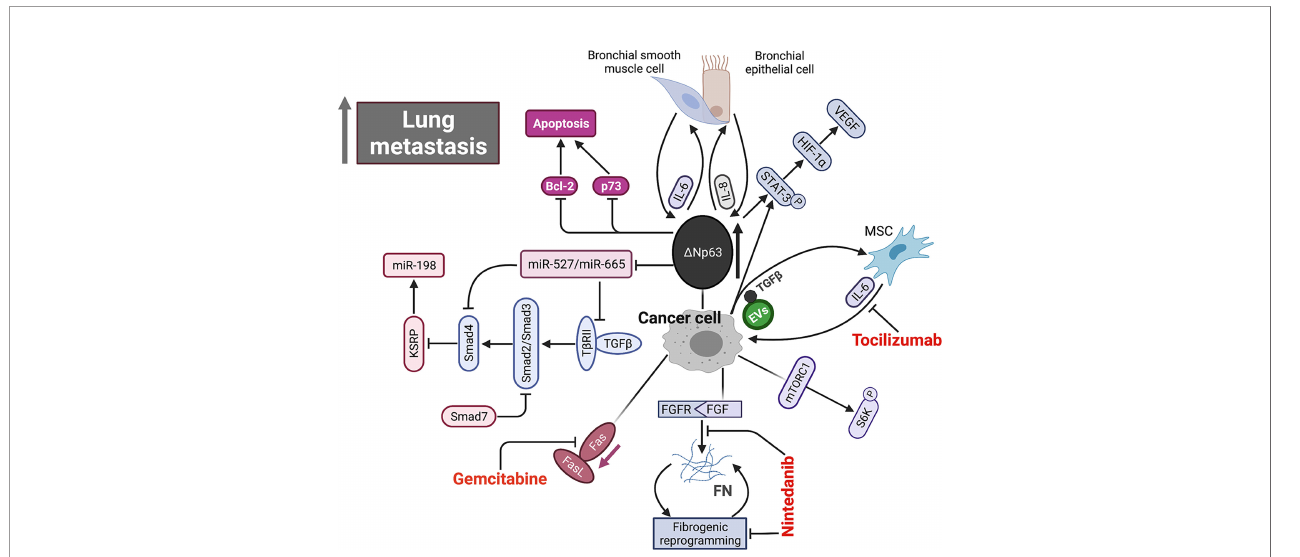
FIGURE 2 | Schematic representation of signaling pathways within microenvironment underlying OS metastasis. Aberrant overexpression of D Np63 in cancer cell directly drives feed-forward ampli fi cation of IL-6 and IL-8 production by the interactions between cancer cell and both primary bronchial epithelial cell and bronchial smooth muscle cell. D Np63 overexpression leads to elevated phosphorylation of STAT-3, which further activates HIF-1 a /VEGF axis. High expression of D Np63 promotes cancer cell survival by inhibiting Bcl-2 and p73-depedent apoptosis. In addition, D Np63 represses miR-527 and miR-665, leading to the upregulation of two TGF- b effectors, Smad4 and T b RII, which inhibits anti-metastasis miR-198 by suppressing its regulatory factor, KSRP. FGF signaling initiates and FN signaling sustains fi brotic reprogramming. Nintedanib targets the pan FGFR-FN axis to inhibit OS lung metastasis. Fas-negative OS cells are selected during metastasis by evading elimination in lung where Fas ligand (FasL) is constitutively expressed. Gemcitabine appears to be a promising agent by upregulating Fas expression. EVs secreted by OS cells selectively incorporate a membrane-associated form of TGF- b and induce IL-6 production by MSCs, which in turn promotes OS progression. IL-6, interleukin-6; IL-8, interleukin-8; STAT-3, signal transducer and activator of transcription 3; HIF-1 a , hypoxia-inducible factor 1 a ; VEGF, vascular endothelial growth factor; TGF- b , tumor growth factor b ; FGF, fi broblast growth factor; FN, fi bronectin; EVs, extracellular